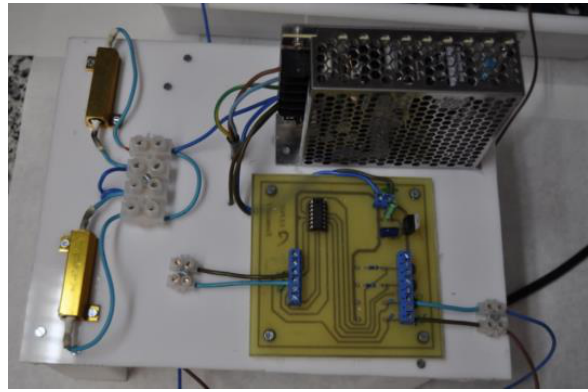
Figure 3. Voltage source and data acquisition system.